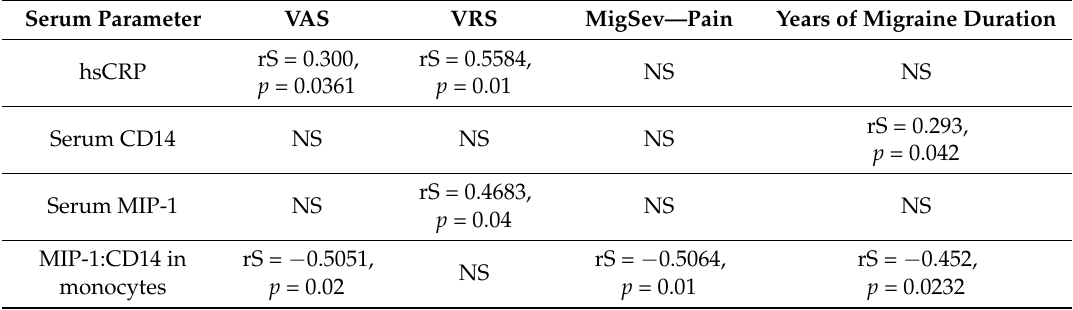
Table 7. Correlations between analyzed cytokines, chemokines, hsCRP and clinimetric measures in migraine